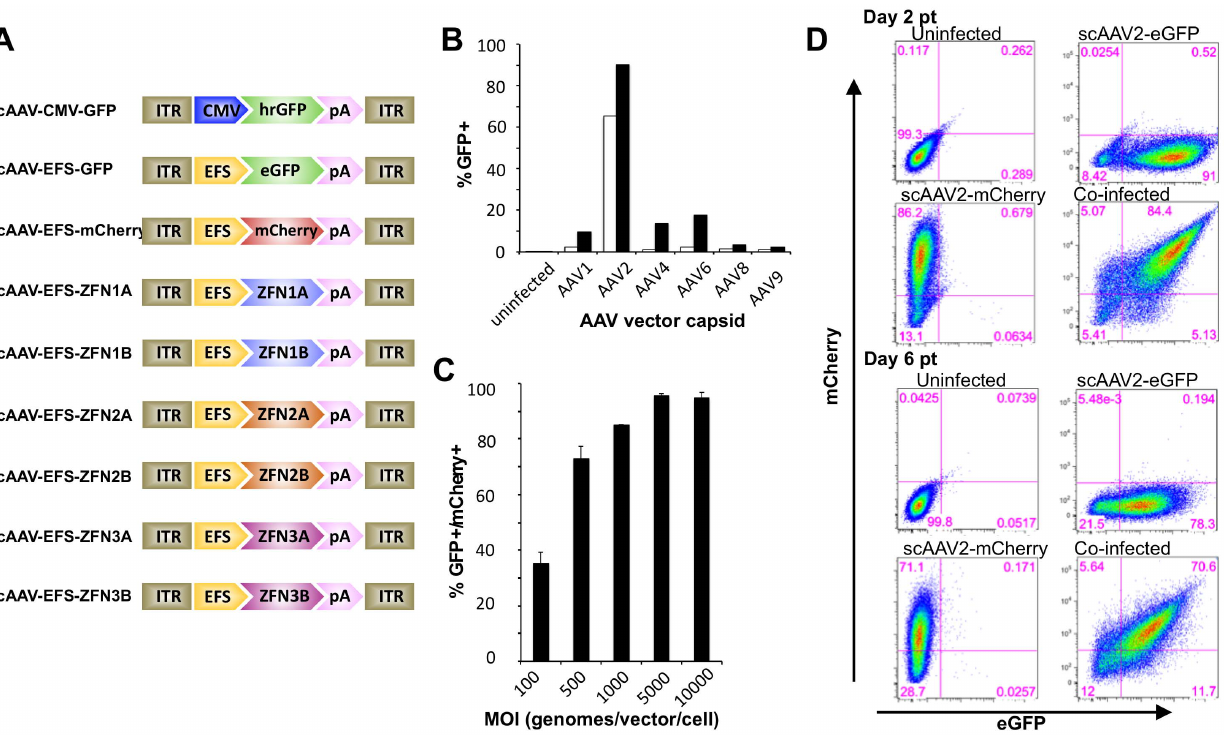
Figure 3. scAAV vector transduction of HepAD38 cells. ( a ) scAAV vector construct organization. ( b ) Cells were transduced with scAAV vectors containing a CMV-hrGFP-pA expression cassette at a MOI of 500 (open bars) or 5000 (closed bars) vector genomes/cell, or ( c ) were co-transduced with scAAV2-EFS-GFP and scAAV2-EFS-mCherry vectors at indicated MOI. Cells were analyzed for GFP and mCherry expression by flow cytometry at 72 hours post infection. ( d ) HepAD38 co-transduction persistence. Cells were transduced with scAAV2-EFS-eGFP and/or scAAV-EFS-mCherry at MOI 5000 genomes/vector/cell and co-transduction levels were monitored by flow cytometry at 2 and 6 days post transduction. ITR – inverted terminal repeat; CMV – cytomegalovirus immediate early promoter; EFS – elongation factor-1a short promoter; hrGFP – humanized Renilla green fluorescent protein; eGFP – enhanced green fluorescent protein; pA – polyadenylation signal; ZFN – zinc finger nuclease.